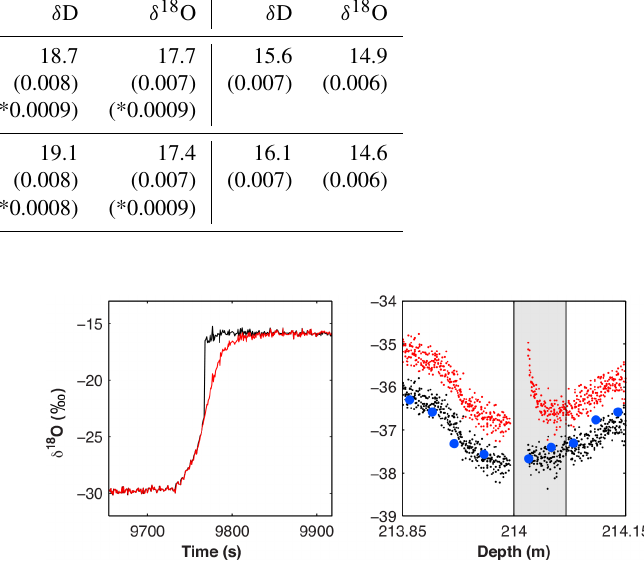
Table 4. Mean mixing length values from 50 determinations of mock ice step changes ( σ mock ice ) and for laboratory isotopic standards step changes ( σ LS ). The difference in quadrature of σ mock ice and σ LS is the amount of mixing occurring in the liquid phase of the CRDS- CFA system ( σ LQD ). Mixing length values for both skew and normal impulse response functions are given in seconds and in meters (in parentheses), based on a melt rate of 2.5cmmin − 1 . Values with an asterisk represent 1 σ variability in meters. σ LS